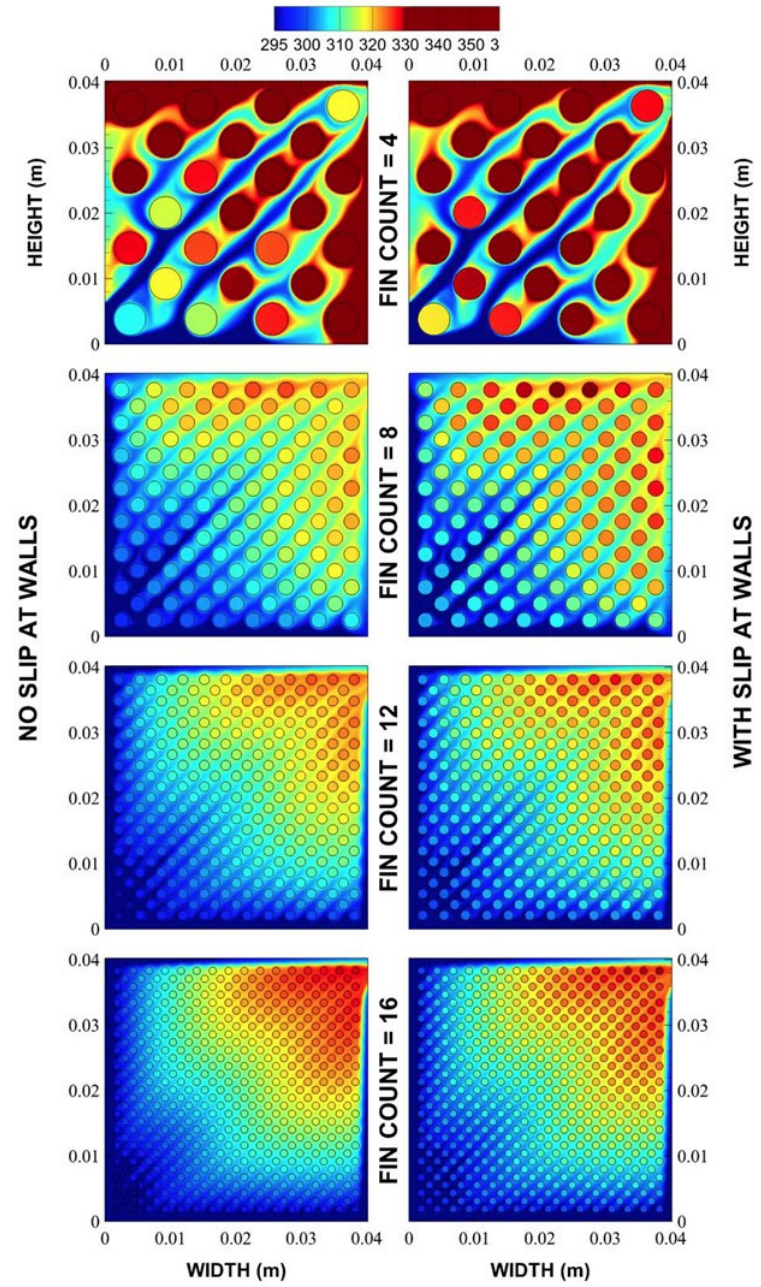
Figure 3. Temperature (K) distribution in the solution domain at the mid-height of the fin for hydrophobic and hydrophilic fin surfaces for a various number of fins and Re = 100.